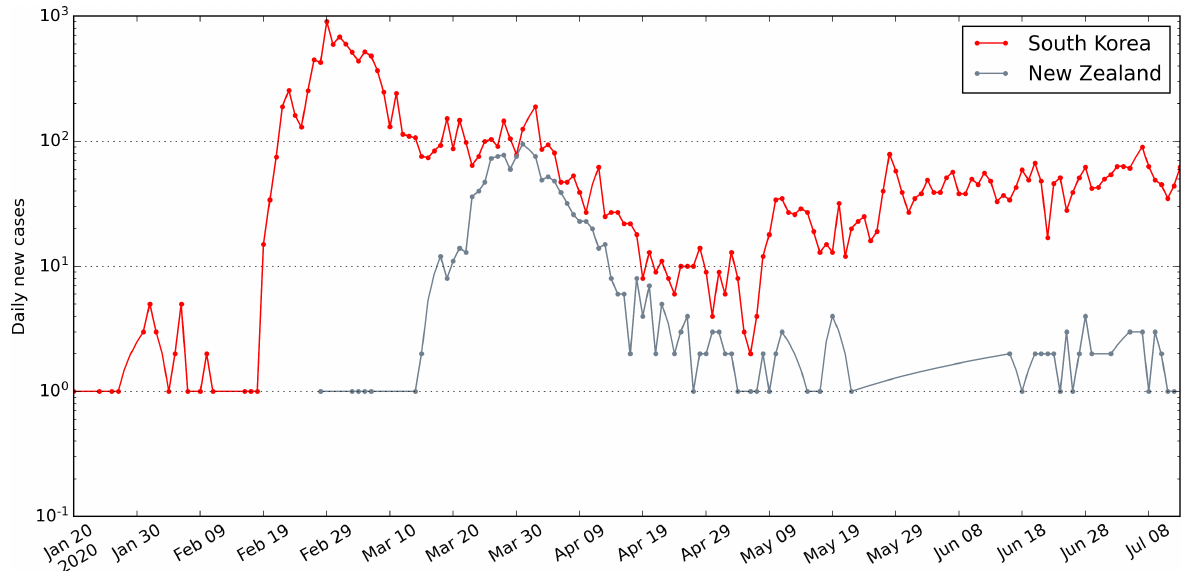
Figure 5. COVID-19 daily cases evolution for successful group countries in log scale. Source Ritchie et al.